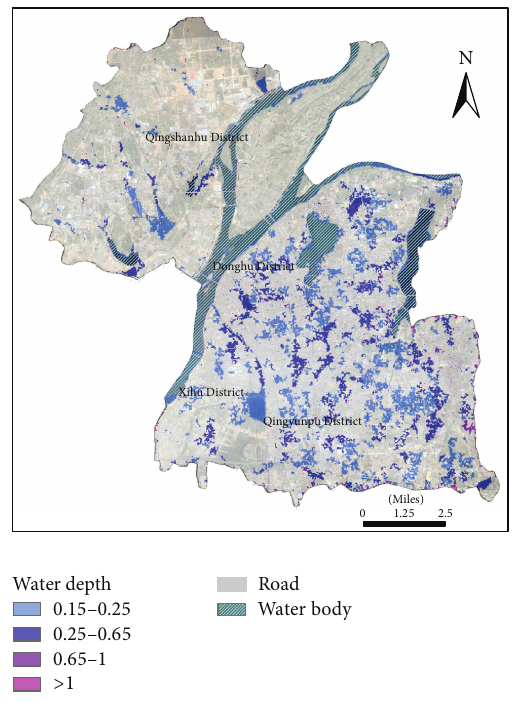
Figure 9: Distribution map of waterlogging in return period of 5 years of Nanchang.